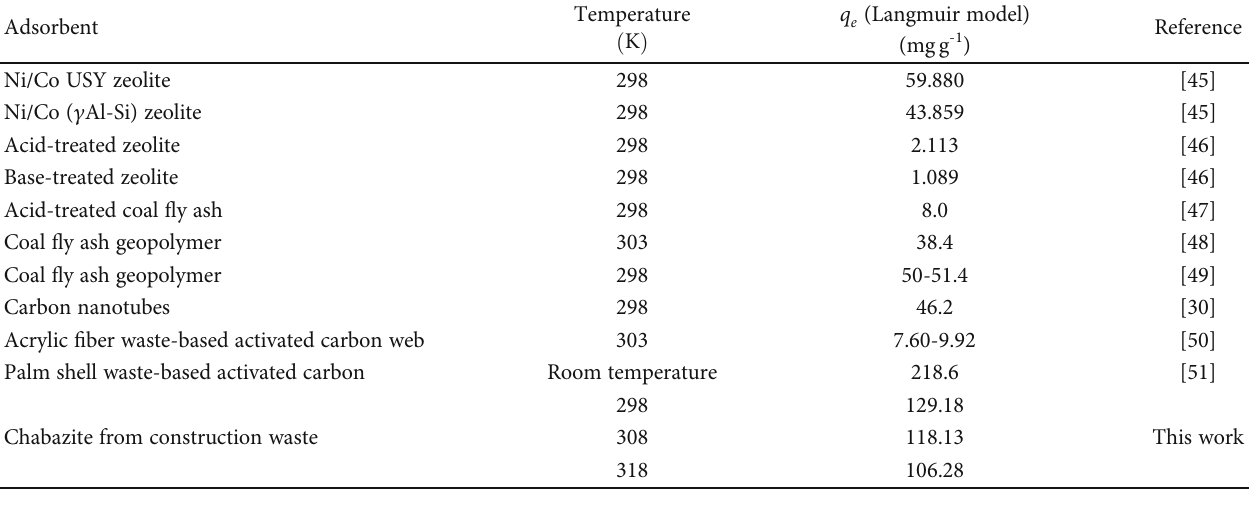
Table 4: Maximum MB adsorption capacity of di ff erent powdery adsorbents reported in literature. Adsorbent